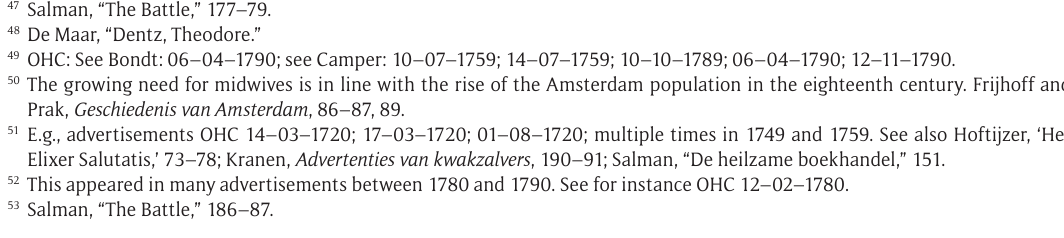
Source: Database OHC